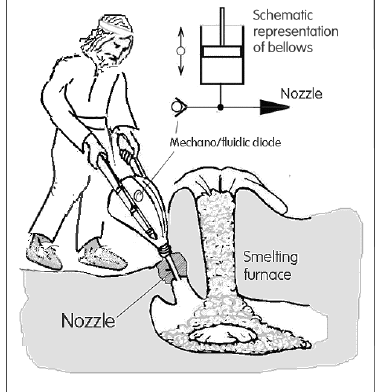
Fig. 1. An example of earliest use of nozzles. Since the Early Bronze Age (~ 4 000 B.C.) nozzles were applied to increasing the temperature in producing metals from ore [4]. Air is here seen being blown into the smelting furnace by bellows through a ceramic nozzle. Reminders of such nozzles are found in large quantities in archaeological excavations [5] .